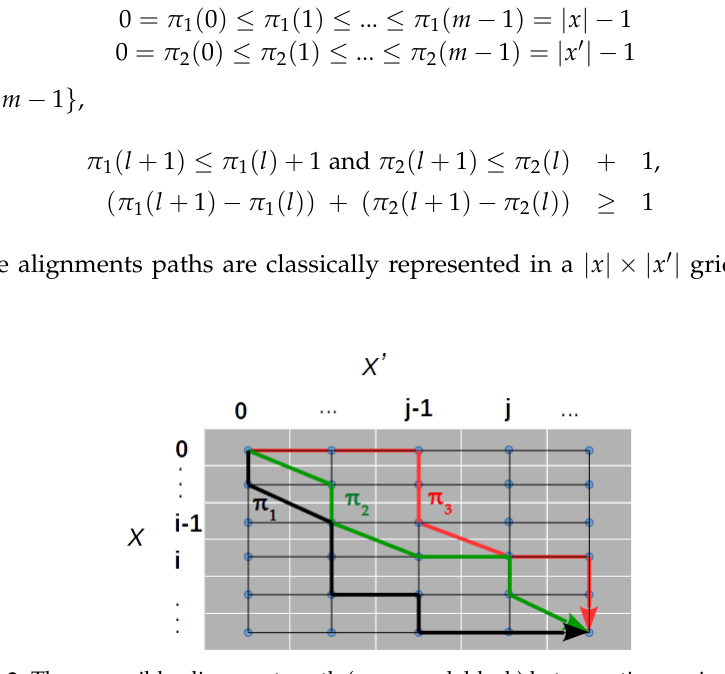
Figure 2. Three possible alignments path (green, red, black) between time series x and x’